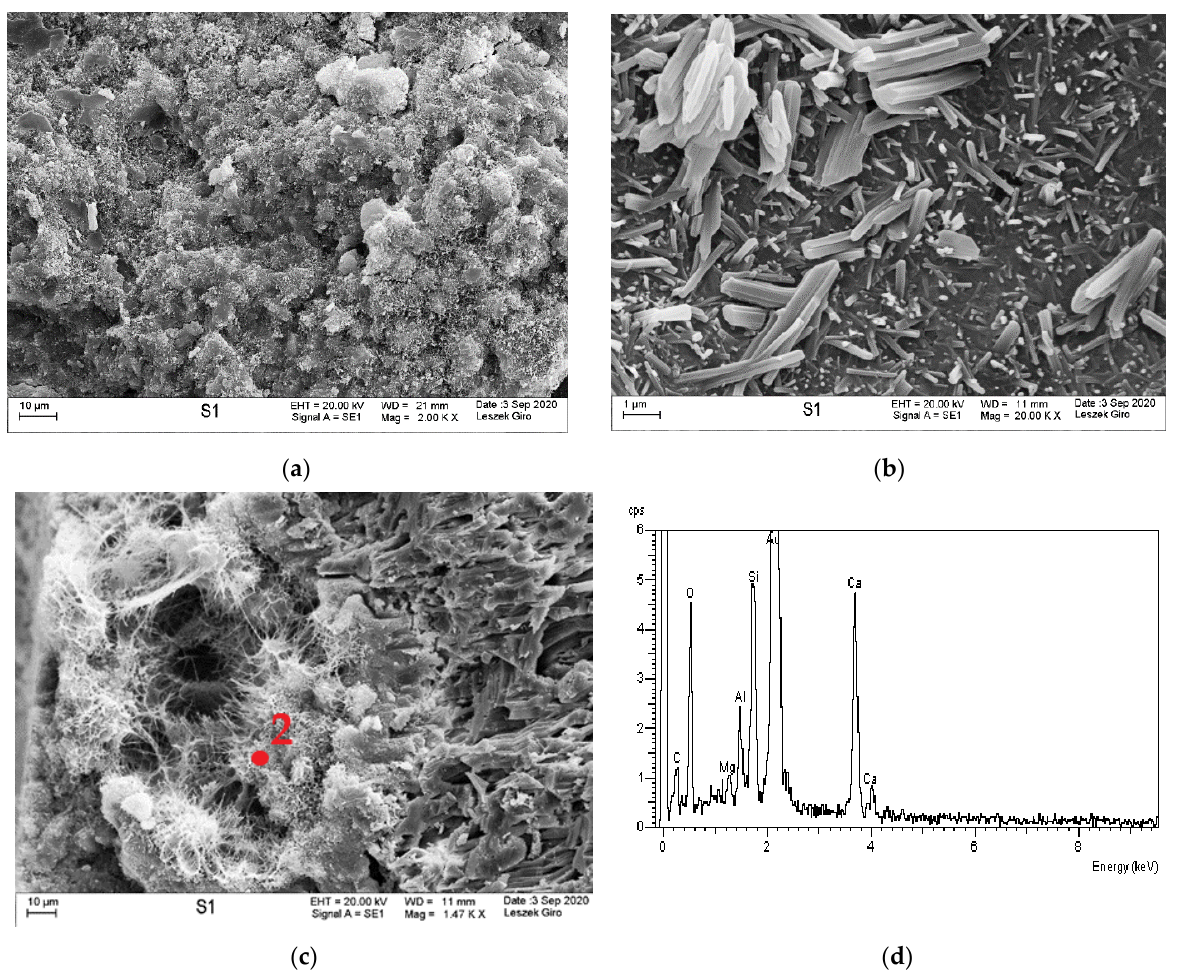
Figure 9. Microstructure of specimens exposed to the action of sulphate ions; C-S-H phase in compact and acicular form ( a ); ettringite columns of pseudo-hexagonal habit ( b ); fibrous forms of hydrated calcium aluminosilicates and irregular CaCO 3 crystals ( c ) and analysis of fibrous forms in micro-area point 2 ( d ).